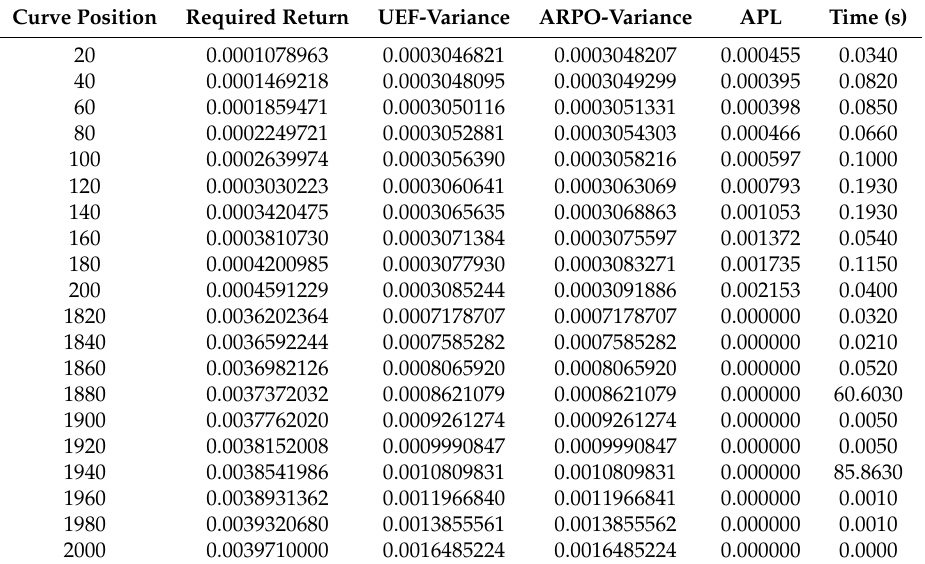
Table 6. NIKKEI Stock Market